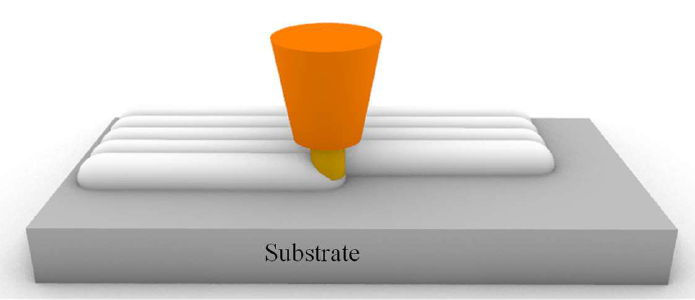
Figure 4. Stringer cladding method.